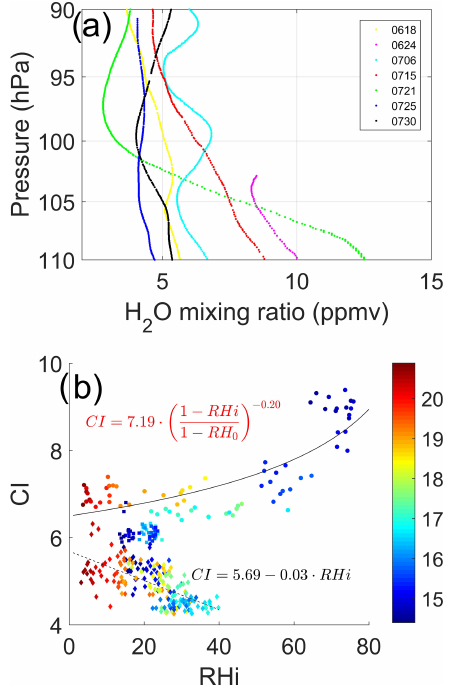
Figure 3. (a) H 2 O mixing ratio from CFH measurements and (b) the variation in CI with RHi between 50 and 150hPa for all cases. The circle, square, and diamond symbols refer to those par- ticles with CI of dry aerosol larger than, close to, and smaller than about 6, respectively. The altitude (in kilometers) where particles were measured is marked with different colors. The two fitted equa- tions exceed the 99% significance